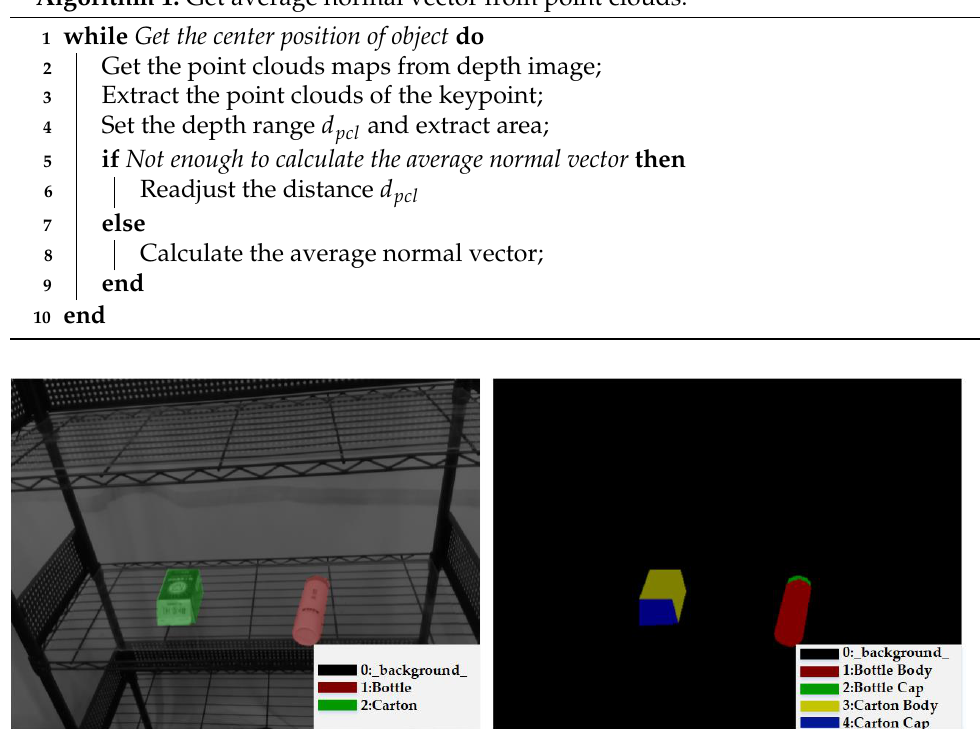
Algorithm 1: Get average normal vector from point clouds.